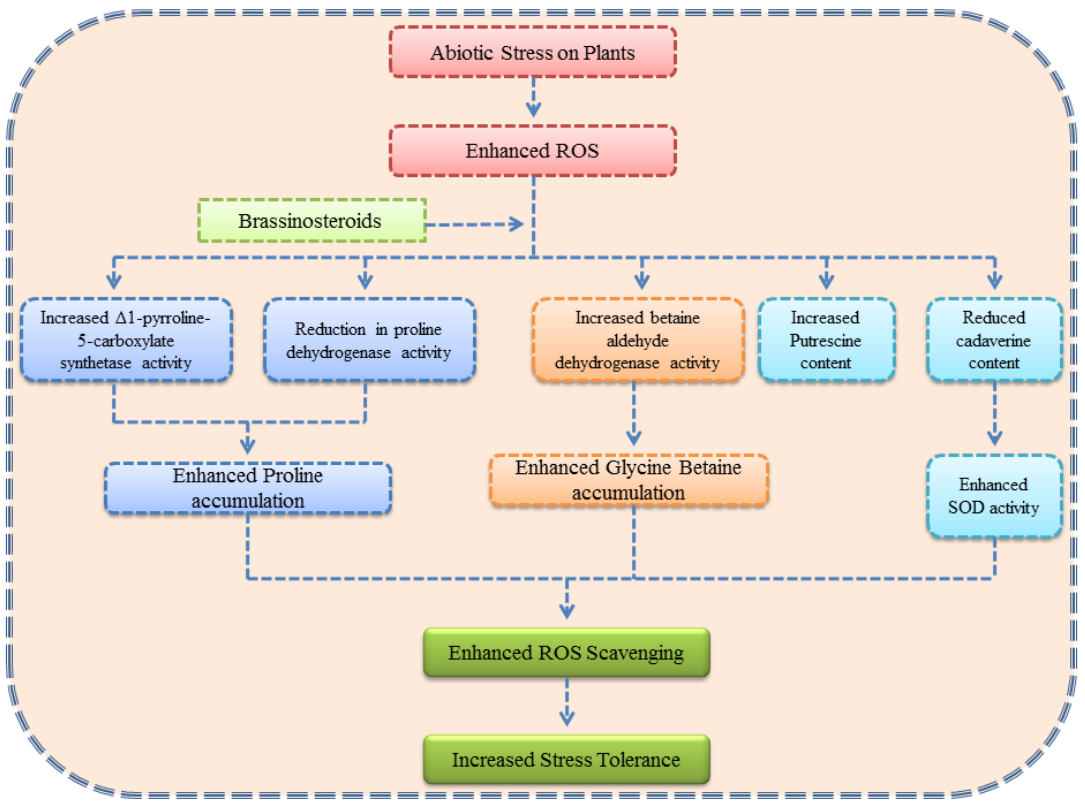
Figure 2. Schematic outline summarizing various effects of brassinosteroids on different osmolytes in plants under stressful conditions.